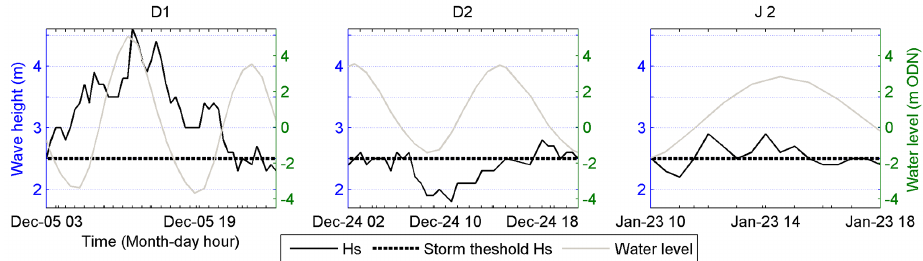
Figure 2. The three selected storm events D1, D2 (in December 2013) and J2 (in January 2014) and their wave height and water level variations together with the storm threshold wave height.